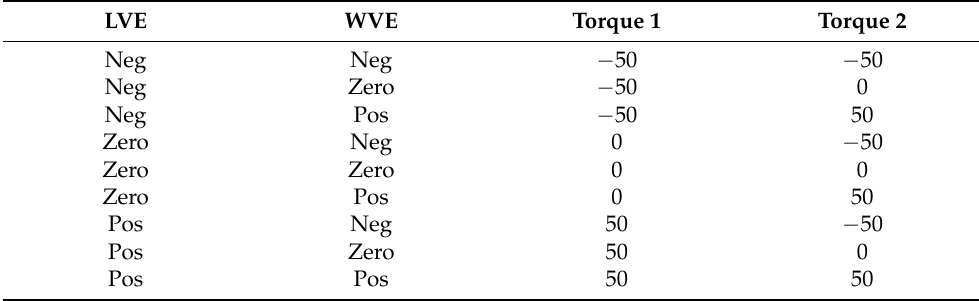
Table 4. Consequents parameters.